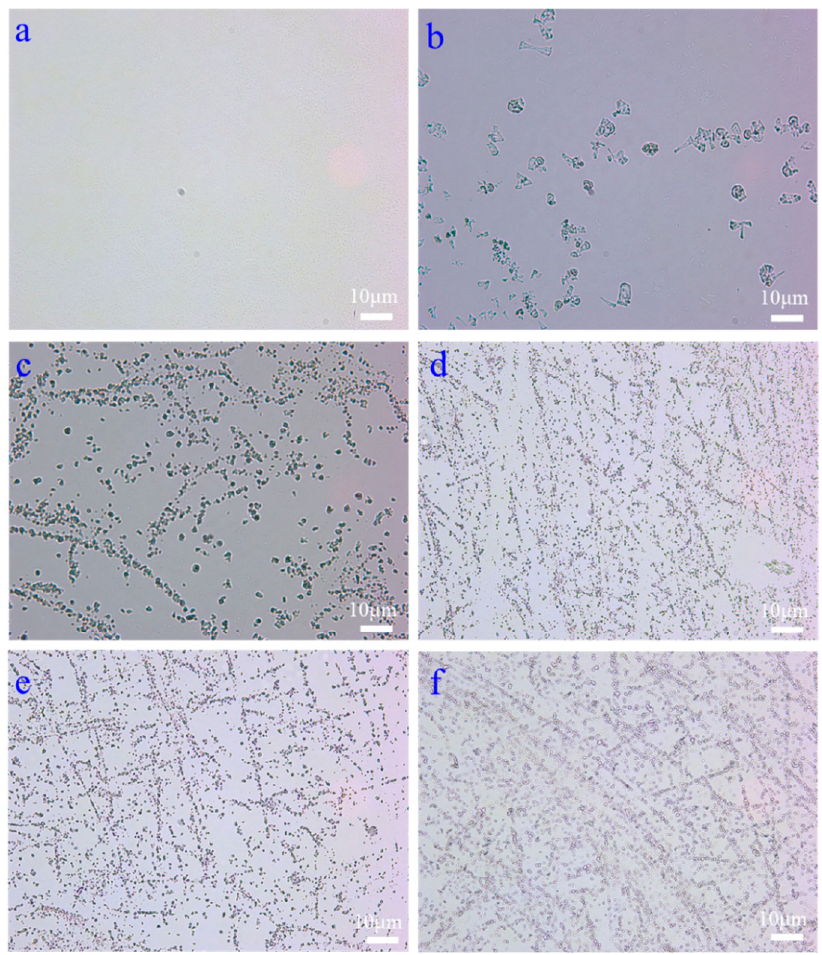
Figure 11. Optical microscope images of the drilling fluid containing 4% different additives after freezing at − 55 °C for 16 h; ( a ) 7:3 base fluid; ( b ) vinyl resin; ( c ) polymethacrylate; ( d ) ethylene propylene copolymer; ( e ) dimeric acid; ( f ) Baker’s organoclay.